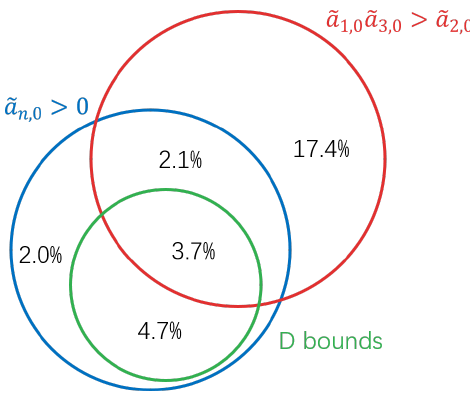
¯ D stu bounds and the nonlinear PQ